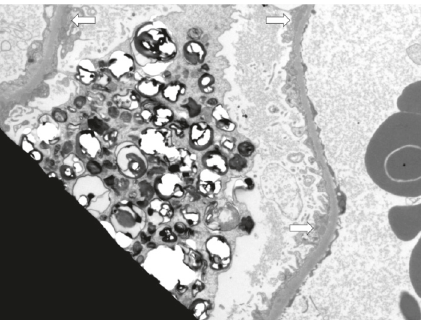
Figure 1: Electron micrograph showing subepithelial electron-dense deposits consistent with class 5 lupus nephritis and intracytoplasmic lamellated bodies (also known as curvilinear bodies-white arrows) within the overlying podocyte. Original magnification 1000 ×